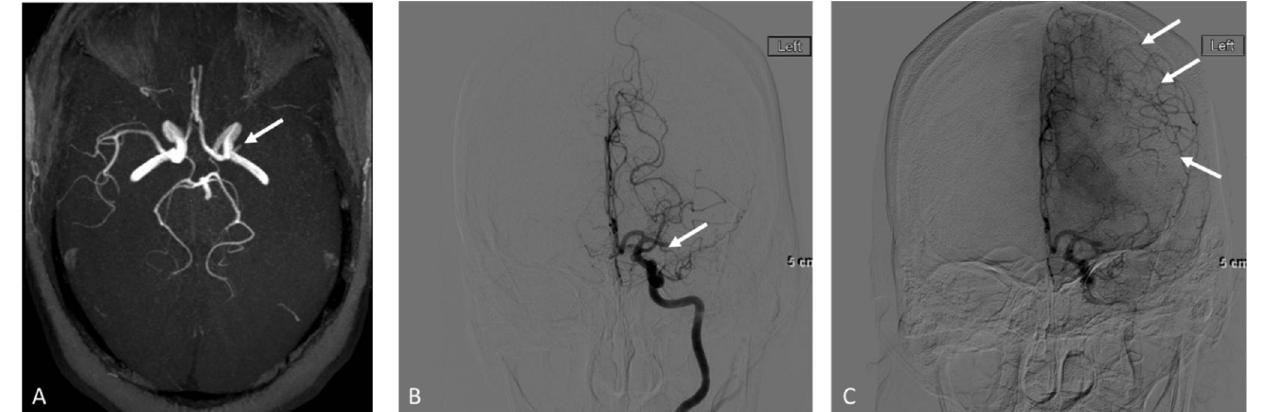
Figure 2. Adult patient who presented with right sided weakness and aphasia, NIHSS: 20. Axial maximum intensity projection from time-of-flight MRA shows left M1 occlusion (arrow in ( A )) and paucity of collaterals along the left MCA territory. Early arterial phase from the follow up digital subtraction angiography confirms M1 occlusion (arrow in ( B )) while later delayed phase imaging demonstrates good collaterals (arrows in ( C )).